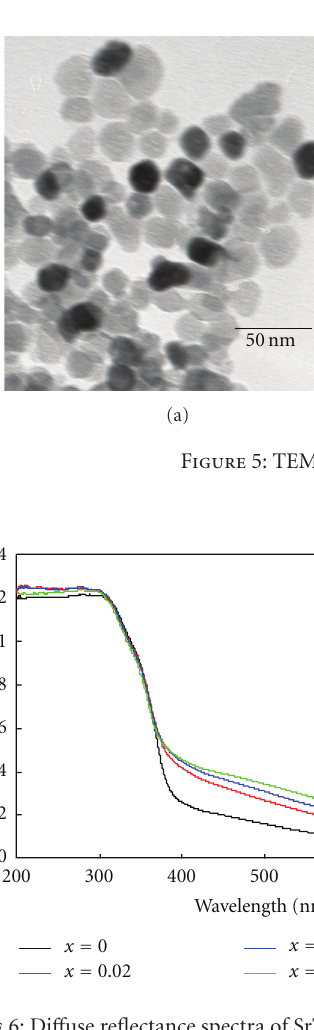
Figure 7: PL spectra of SrTi 1 − x Ta x O 3 − y N y powders ( x = 0 − 0 .